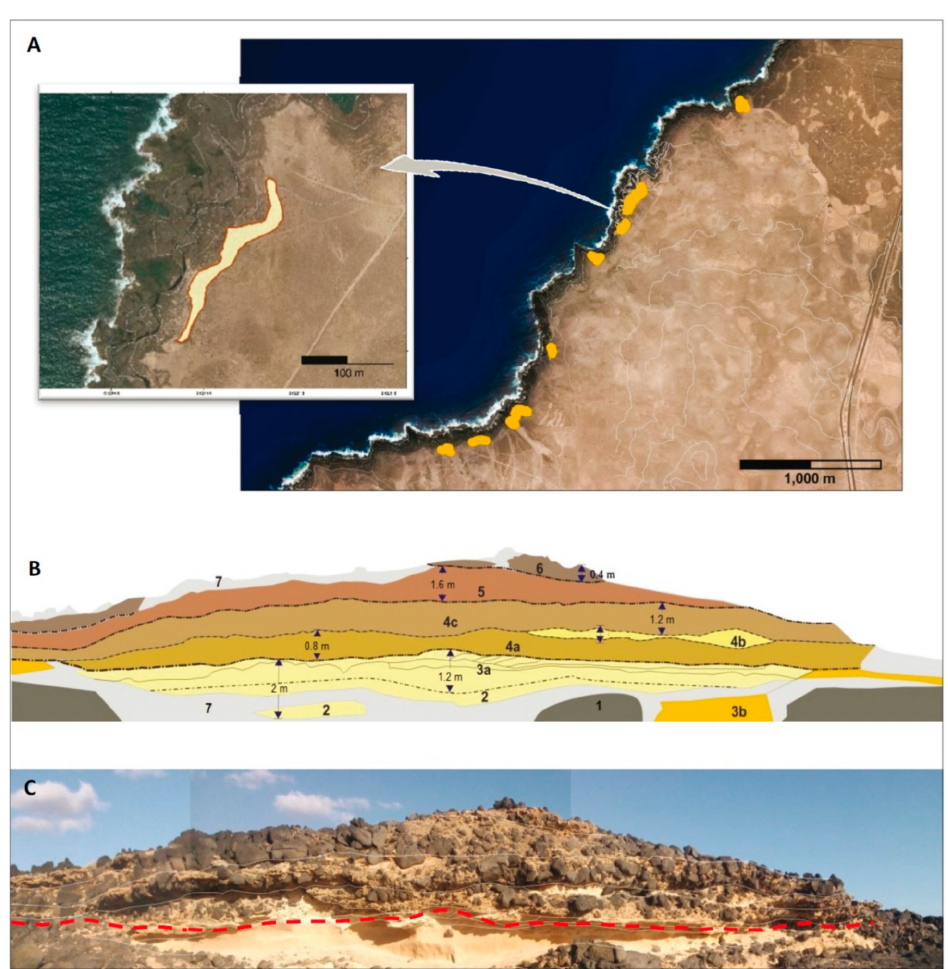
Figure 8. ( A ) Tsunami deposits outcrops scattered along the SW coast of Lanzarote, and location of the main Piedra Alta outcrop. PNOA and Google images. ( B ) Geological cross section of the Piedra Alta deposits in the coastal cliff, at ~20 m a.s.l. 1: underlying lava flow; 2,3: Aeolian sand (paleo dune) and clayey paleosol containing abundant terrestrial fossil fauna, 2 m max.; 4,5,6: tsunami conglomerates showing different layers with erosive contact, cemented sand matrix and basalt angular blocks, terrestrial and marine fossils, 4 m max.; 7: current sandy soil. ( C ) Annotated photograph of the outcrop; length: 30 m (the red line marks the base of the tsunami